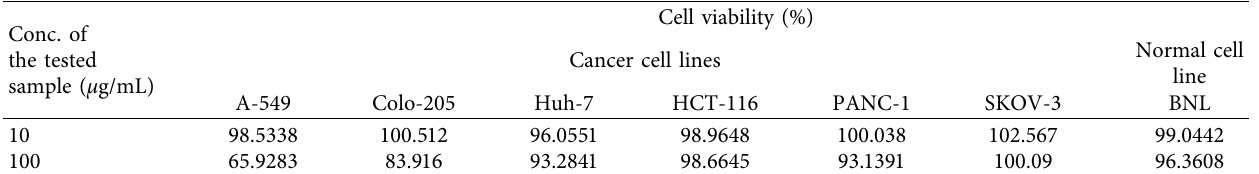
Table 4: Rapid SRB cytotoxicity screening results of total methanolic extract from the whole aerial fowering parts of C. occidentalis on several cell lines.